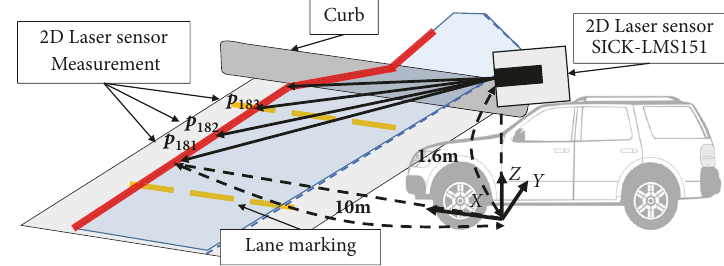
Figure 1: Vehicle configuration and setup of the two-dimensional (2D) laser sensor.